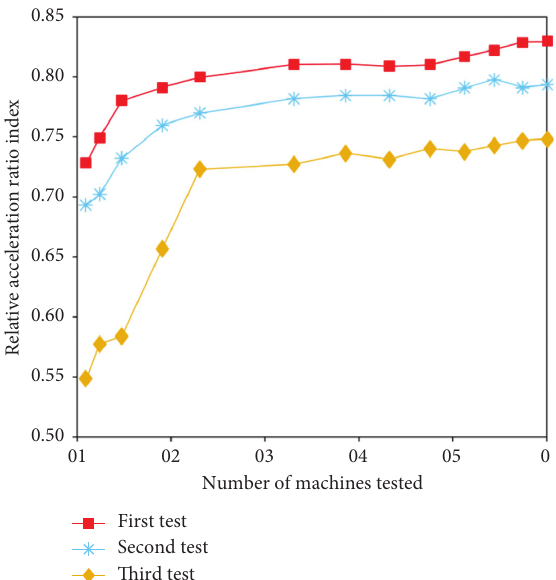
Figure 3: The Hadoop cluster performance acceleration ratio